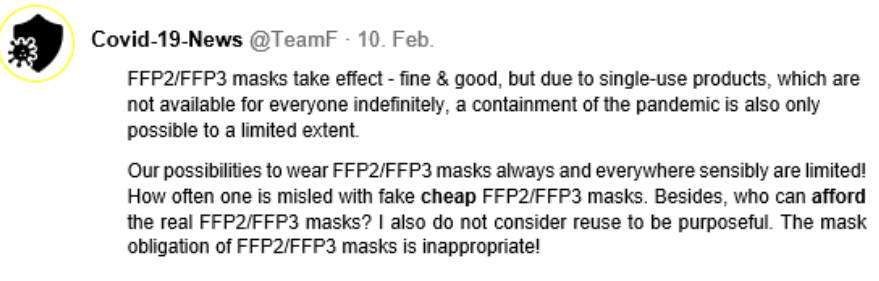
Figure A6. Conspiracy-theoretical Posting Team F. Note. Predictor media content: conspiracy-theoretical Posting Team F. Originally presented in German. Translation: “FFP2/FFP3-Masken wirken—